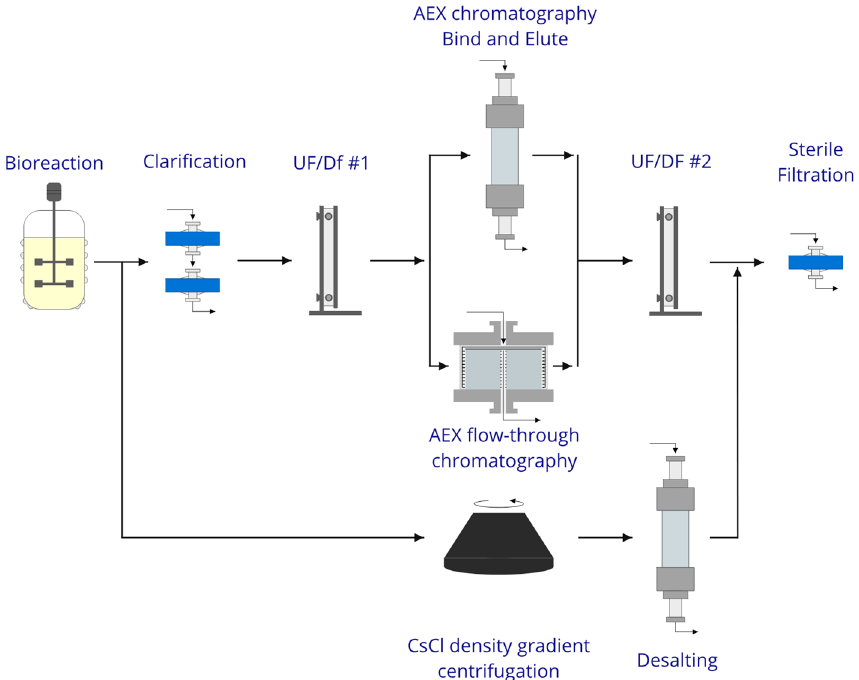
Figure 1. Possible processing routes for hepatitis C virus-like particles (VLP); clarification performed using a train of depth filters; concentration and buffer exchange using tangential flow filtration with membrane cassettes devices.